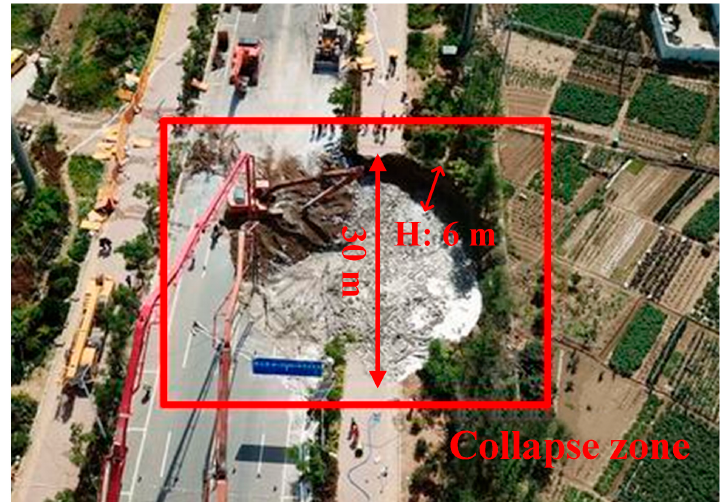
Figure 5. Ground collapse.